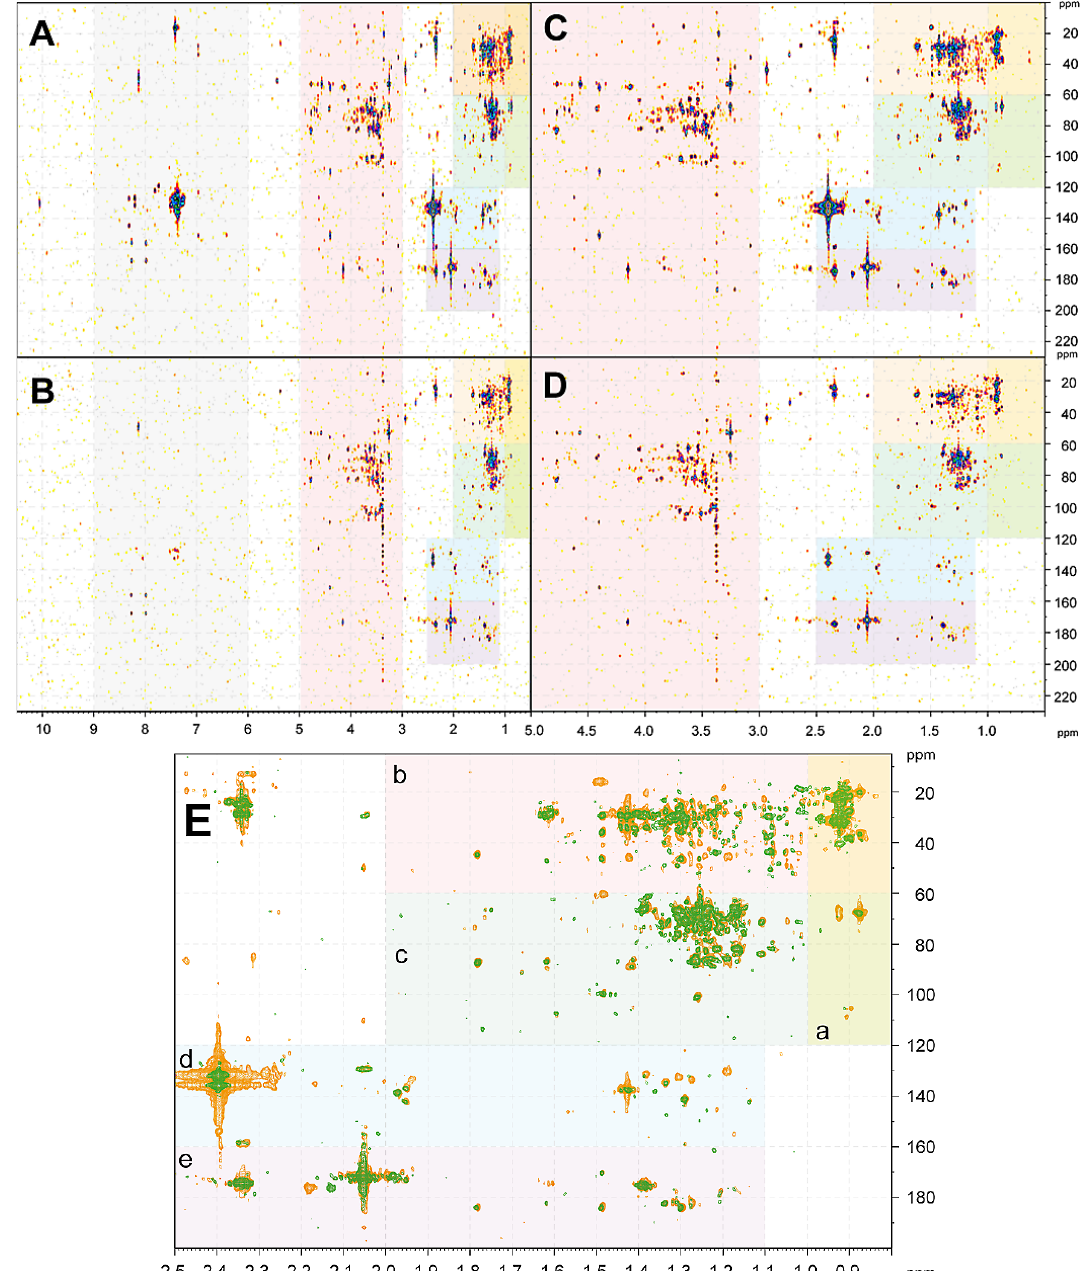
Fig. 10. 1 H, 13 CHMBC spectra of (A, C) surface SPE-DOM at 5m (near-surface photic zone) and (B, D) SPE DOM at 48m (fluorescence maximum). Color code as provided for (E) , with additional oxygenated units (red) H C n - C H-O ( n = 1,2; δ H ∼ 3–5ppm) and unsaturated units (grey) H C n - C ( n = 1,2; δ H ∼ 6–9ppm). (E) Superposition of surface SPE-DOM at 5m (orange) and 48m (green) HMBC aliphatic section sp 2 cross peaks with substructure regimes indicated in color: section a: HMBC cross peaks 2 , 3 J CH connecting methyl with various groups: H 3 C- (C) C C ( δ C < 60ppm), H 3 C-(C) C O ( δ C ∼ 60–100ppm), and H 3 C-(C) C O 2 ( δ C ∼ 100–120ppm); section b: intra-aliphatic HMBC cross peaks H C(C) C ( 2 , 3 J CH ); section c: intra-aliphatic HMBC cross peaks H C(C) C O ( 2 , 3 J CH ); section d: HMBC cross peak connecting aliphatic protons with sp 2 -hybridized carbon (olefin or aromatics) H C al (C) C ( 2 , 3 J CH ); and section e: HMBC cross peak connecting aliphatic sp 2 protons with carbonyl carbon (olefin or aromatics) H C al (C) C (=O)X ( 2 , 3 J CH